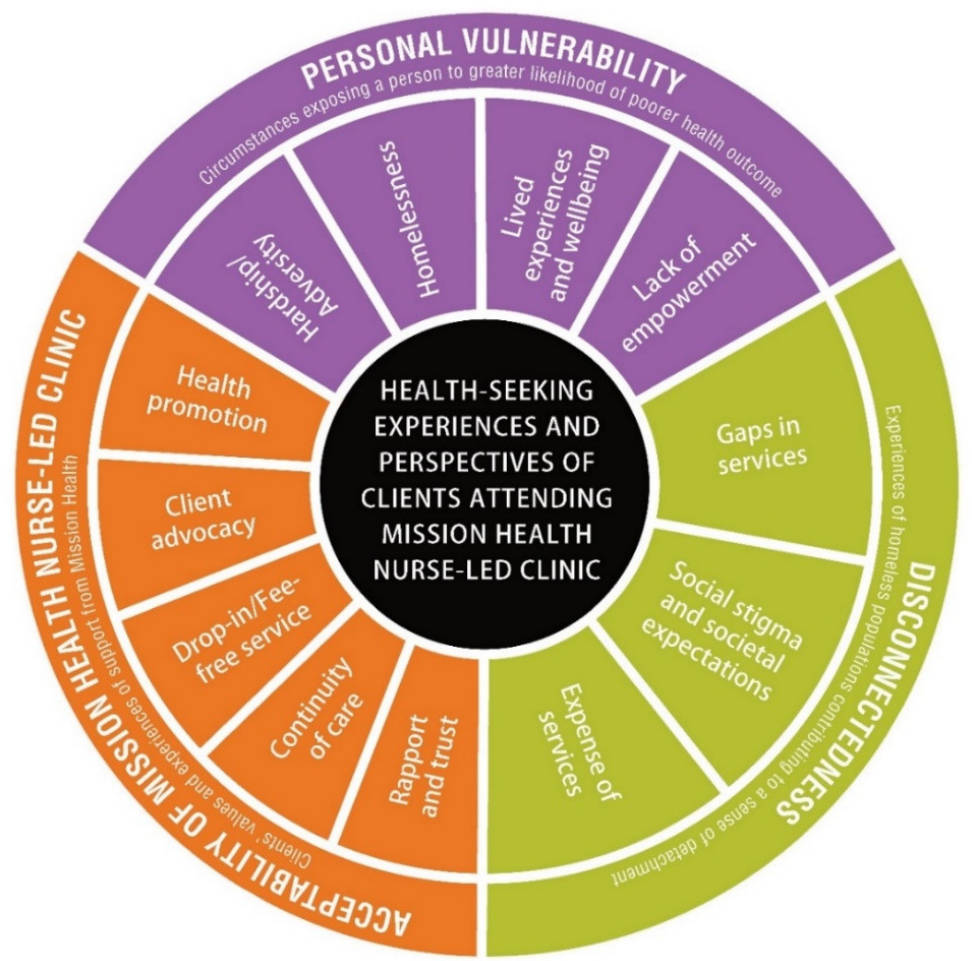
Figure 2. Health-seeking experiences and perspectives of clients attending Mission Health Nurse- led Clinic.